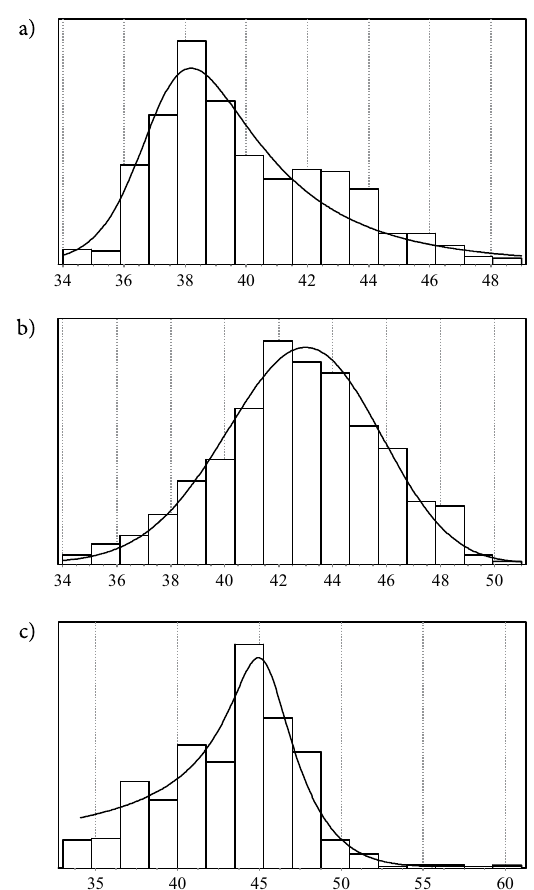
Fig. 7. a – overall empirical frequency histogram of the individual rebound indices (no separation by location) together with the best goodness of fit probability density function for the L-type original Schmidt rebound hammer; b – overall empirical frequency histogram of the individual rebound indices (no separation by location) together with the best goodness of fit probability density function for the N-type original Schmidt rebound hammer; c – overall empirical frequency histogram of the individual rebound indices (no separation by location) together with the best goodness of fit probability density function for the N-type Silver Schmidt rebound